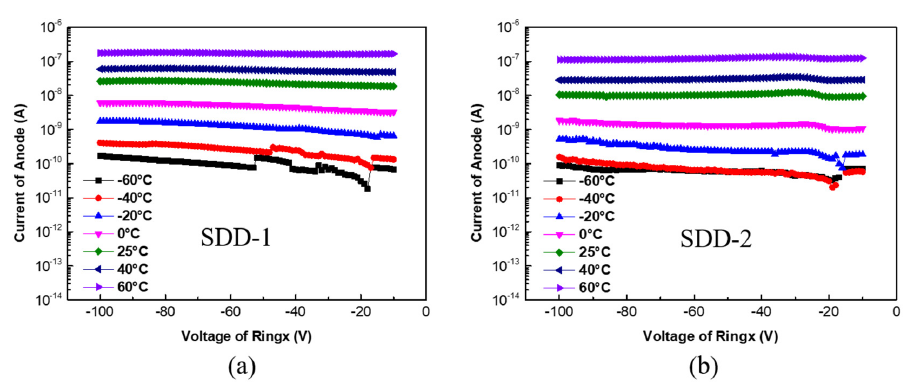
Figure 7. ( a , b ) The anode current of SDD-1 and SDD-2 at the temperature range from − 60 °C to 60 °C, respectively.